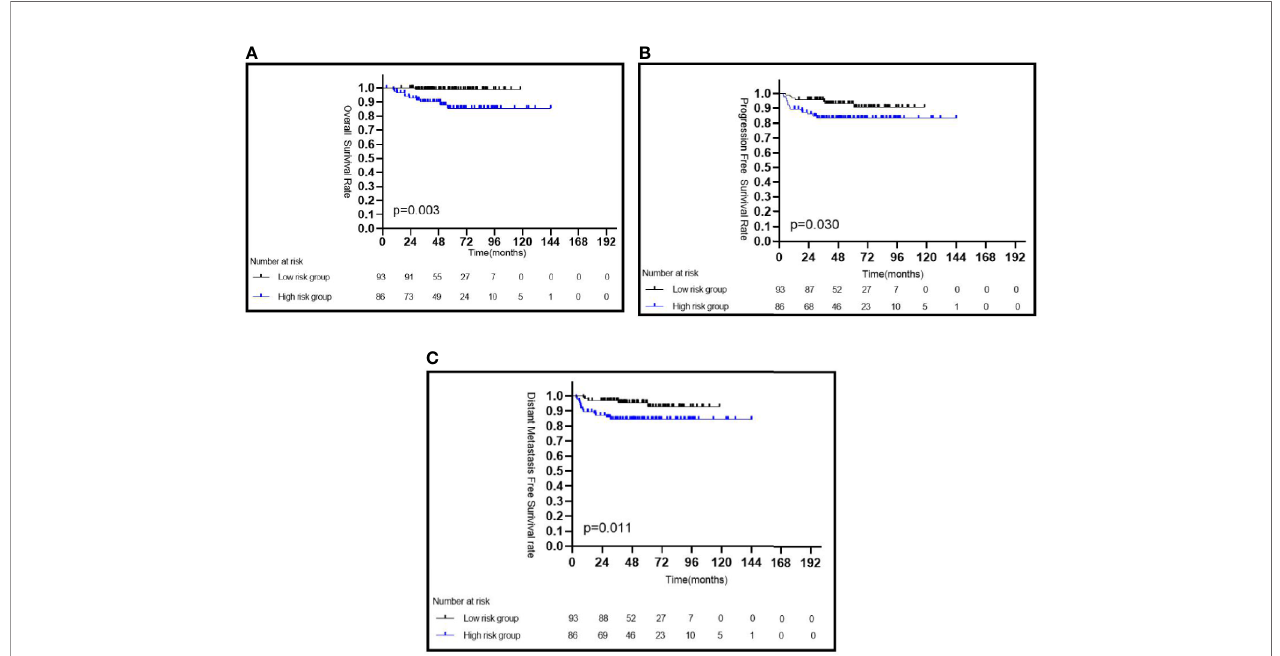
FIGURE 1 | Kaplan – Meier survival curves of CaNPC in different risk groups based on pEBV-DNA (A – C) . pEBV-DNA, pretreatment Epstein-Barr virus DNA.